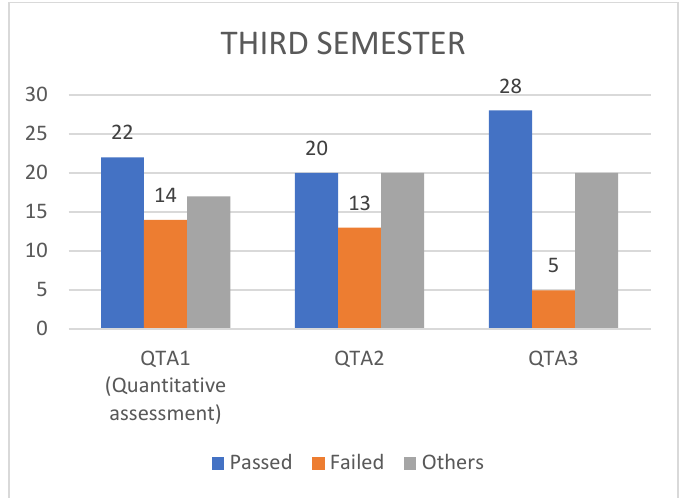
Fig. 4. Number of evaluations given in the third semester. Source: Author.